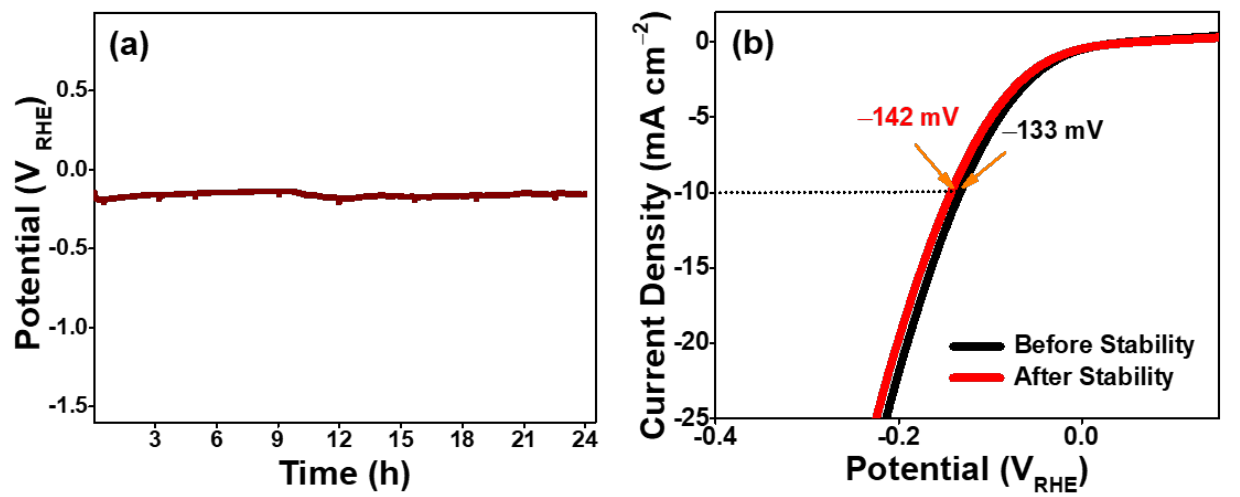
Figure 6. ( a ) Stability curve of synthesized H-PCM electrode was recorded in 0.5 M H 2 SO 4 aqueous solution towards HER for 24 h and ( b ) linear sweep voltammetry polarization curves of synthesized H-PCM electrode obtained before and after prolonged stability. Table 1. The HER performances of H-PCM were compared with the reported ones.